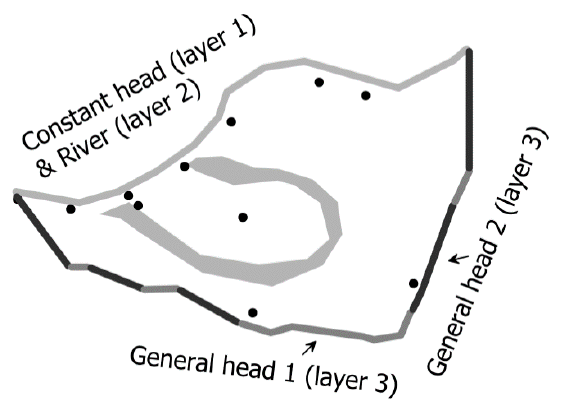
Figure 5. Conceptual model showing boundary conditions and locations of 11 the monitoring wells.